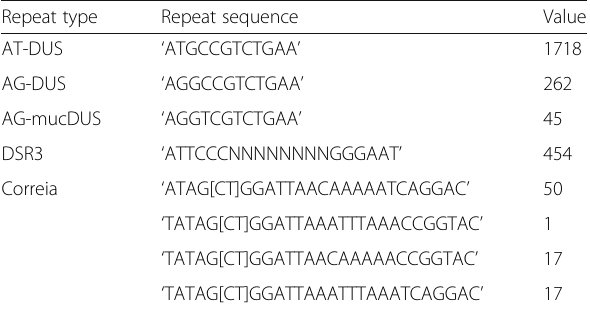
Table 5 Frequency of repeat sequences in N. lactamica Y92 – 1009 genome